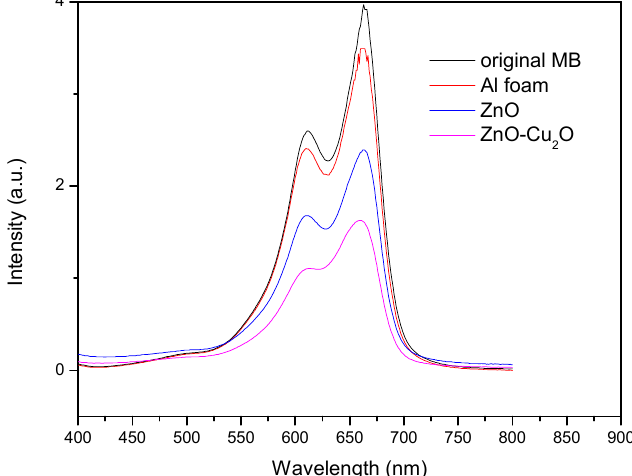
Figure 5. The pseudo-first-order kinetics fit the concentration as a function of time.